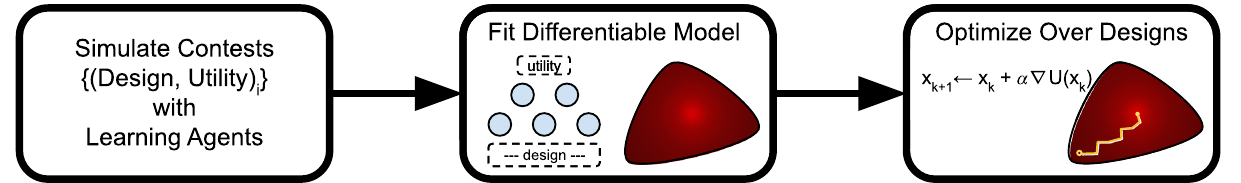
Figure 1. Diagram of the contest design process (Algorithm 2). Step (1) Simulate contests and agent learning to determine the utility of possible designs. Each data point represents a (contest design, auctioneer